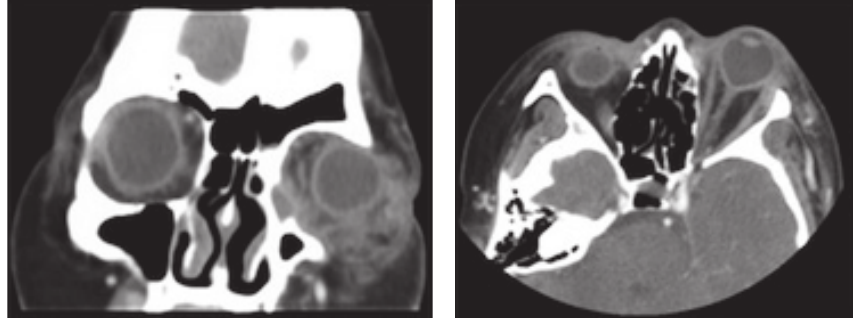
Figure 3: Coronal and axial CT of the orbits with contrast showing an enlarged left lacrimal sac, a large complex fluid collection in the inferomedial left orbit, and severe tenting of the posterior globe. The lacrimal sac is smaller in size compared to Figure 1 suggestive of posterior rupture into the orbit causing decompression of the